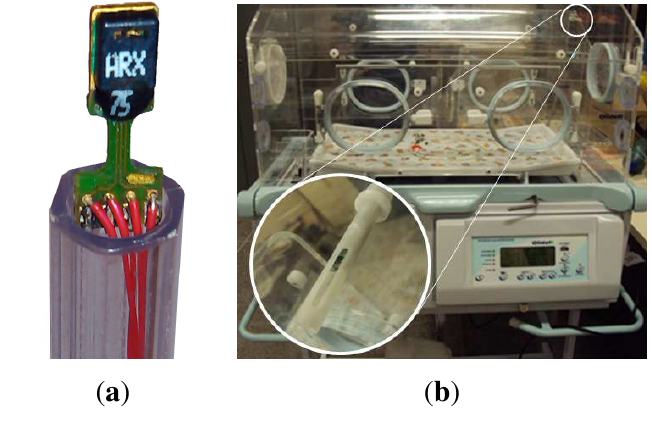
Figure 3. ( a ) Sensor SHT11; ( b ) position of sensor SHT11 in the